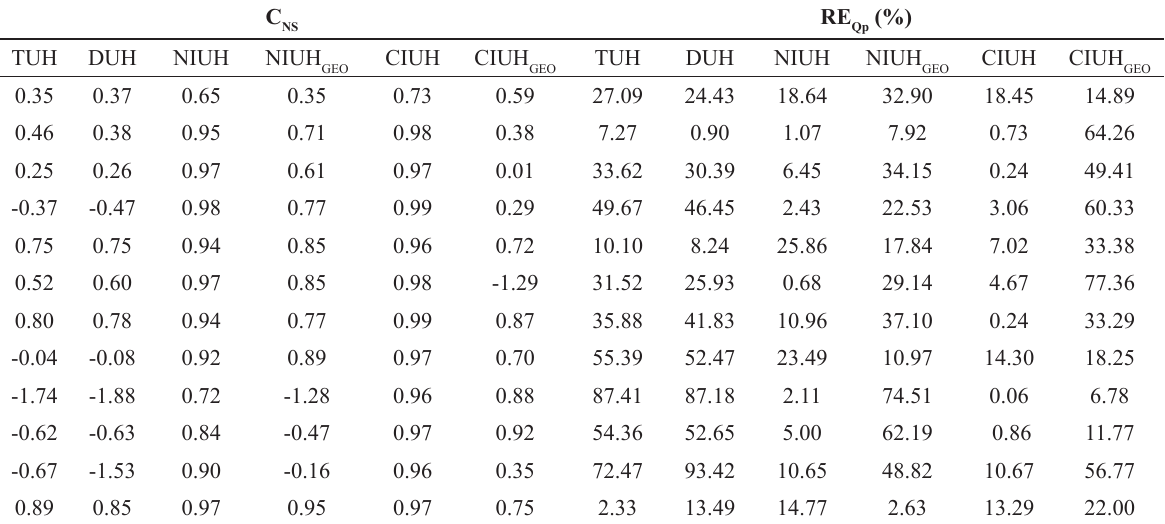
Nash-Sutcliffe coefficient (C ) and peak stream flow relative error (RE NS CRW, considering the UH and IUH models analyzed in this